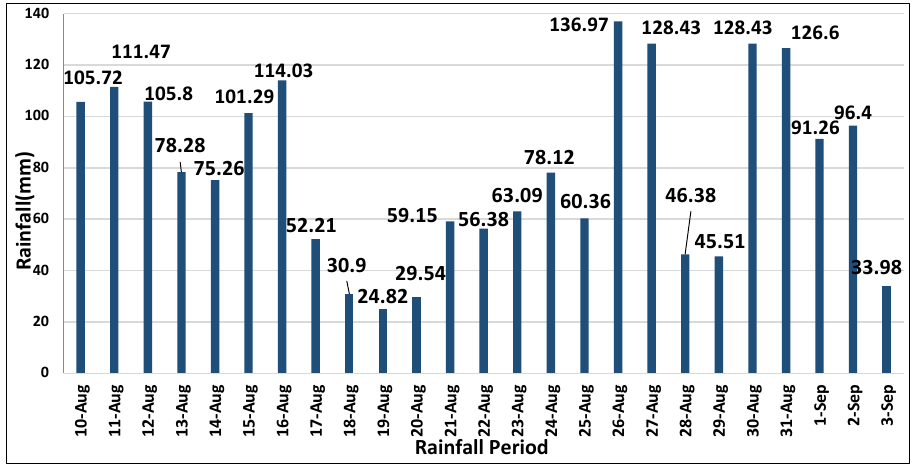
Figure A2. Daily rainfall amount over the Kosi and Gandak river catchment (mm) during flooding period from 10 August–3rd September, 2017 as derived from TRMM (3B42RT) data.